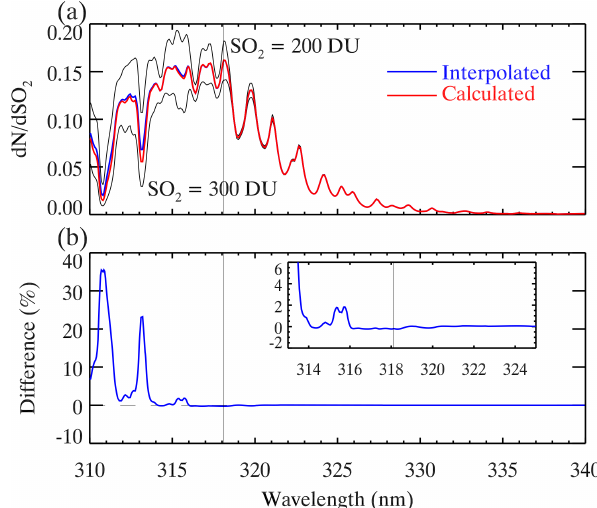
Figure 2. (a) A comparison of SO 2 Jacobians for an idealized pixel (SZA = 30 ◦ , VZA = 45 ◦ , RAZ = 90 ◦ , R = 0.05, an SO 2 plume = 250DU, and a midlatitude O centered at 18km with (cid:127) SO 3 pro- 2 = 375DU) derived from direct calculation using VLI- file with (cid:127) O 3 DORT (red line) and interpolation (blue line) from VLIDORT cal- culations for two bracketing SO 2 nodes (200 and 300DU) shows sizable (b) interpolation errors at wavelengths <315nm, caused by nonlinearity owing to the saturation of SO 2 absorption signals. The relative difference between interpolated and directly calculated SO 2 Jacobians exceeds 30% at wavelengths <315nm and remains sub- stantial at about 2% at ∼ 316nm (see insert). The wavelength with the maximum interpolated SO 2 Jacobian, or the start of the fitting window for this particular example, is ∼ 318nm and is marked with a vertical solid line in both (a) and (b)